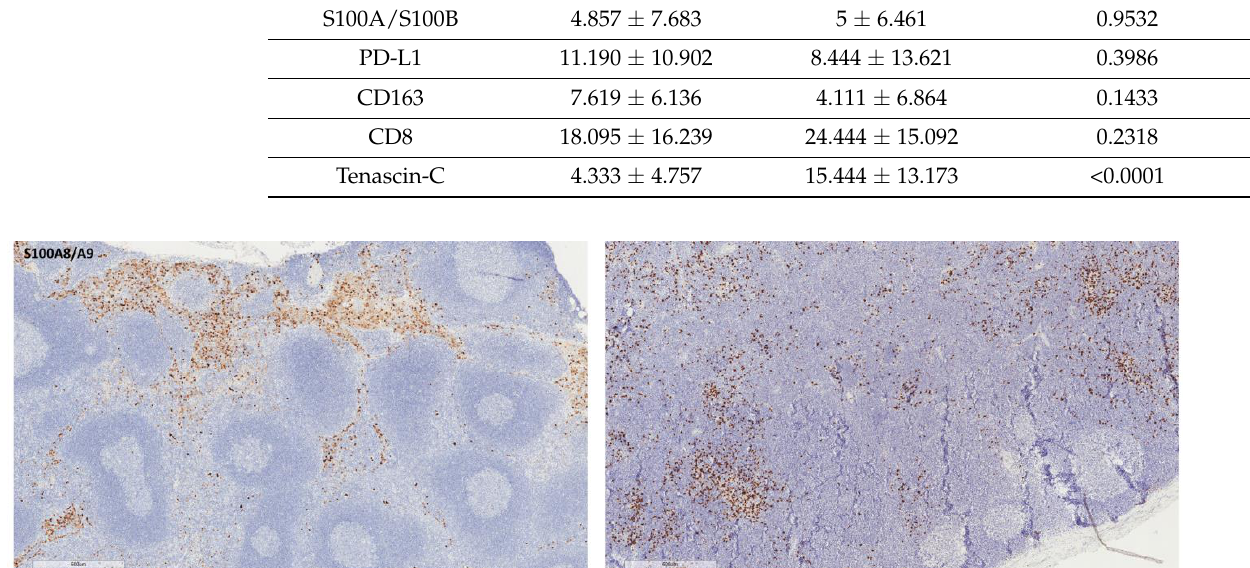
Figure 1. Representative microscopic images of S100A8/A9 expression in a normal cancer-draining lymph node ( A ) and a normal non-cancer-draining lymph node ( B ).